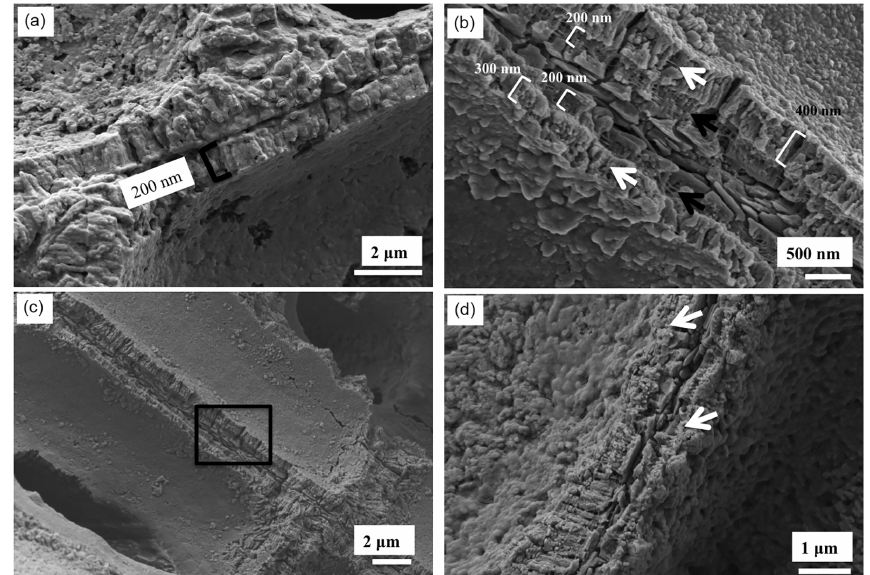
Figure 10. Hypothallus and transitional cells in L. laeve . Cleaned 2min. (a) Hypothallus underside. Organic film covering wall structures. Walls ∼ 200nm wide, roughly radial structure within cell wall. (b) Cleaned 2min, hypothallus in upper crust. Roughly radial structure within cell walls. Black box enlarged in (c) . (c) The wall adjacent to the interfilament is narrowest at ∼ 200nm, has closely spaced organic fibrils (black arrows) and is poorly calcified compared to the inner part of the wall (300–400nm wide) where radial grains are present. There are fibrils parallel to the cell wall appearing to go through the wall grains similarly to the perithallial cell walls (white arrows). (d) Transitional cell wall. The calcification in the lower of the left side wall is comparable to the perithallial cell wall with radial grains. The right side wall and upper part of the left side (white arrows) are poorly calcified and appear as a calcified membrane rather than a properly developed cell